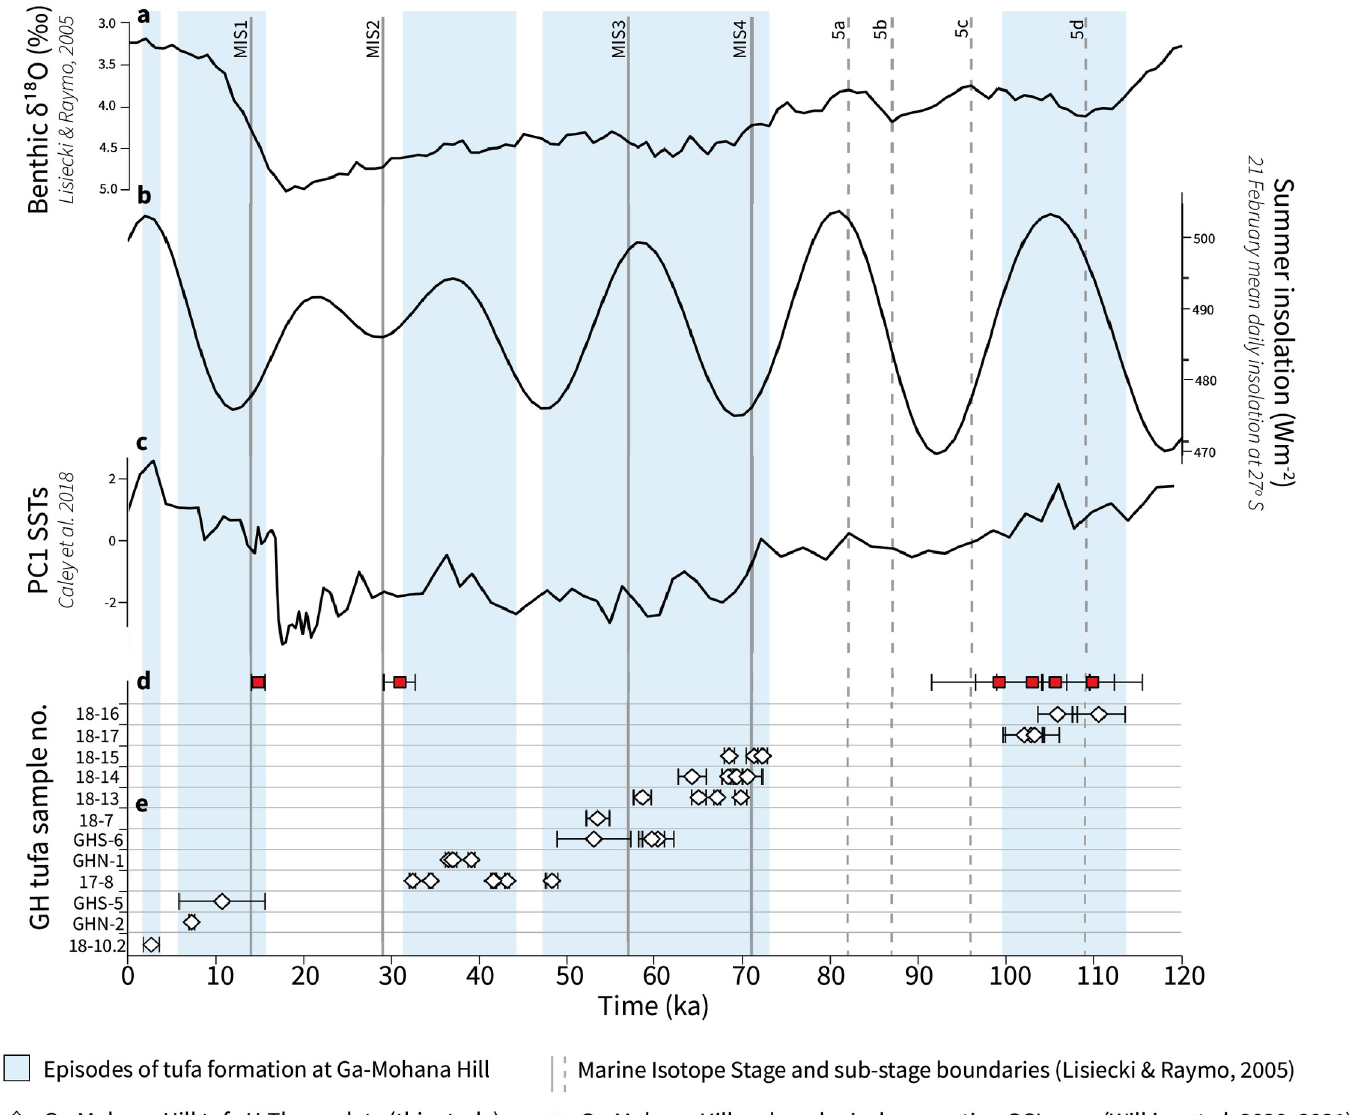
Fig 3. Composite plot of Ga-Mohana Hill tufa formation compared to selected global proxies over the last 120 ka. ( A ) LR04 curve [61]; ( B ) variance of reconstructed sea surface temperatures (SST) from Indian Ocean core MD96-2048 [62]; ( C ) mean daily summer insolation curve for 27 o S [63]; ( D ) OSL age data from the Ga-Mohana Hill North excavation sediments [27, 36]; ( E ) tufa U-Th age data with 2 σ error bars presented in Table 1. The blue bars highlight clusters of overlapping tufa ages and are defined by the minimum and maximum ages in each range, calculated using the 2 σ uncertainty associated with the ages. Based on the presence of the tufa deposits, these periods are inferred to represent episodes of greater water availability on the